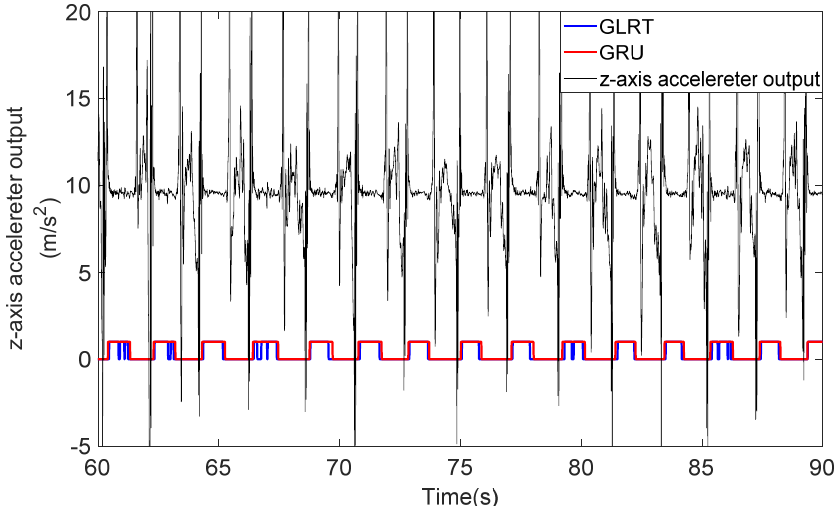
Figure 6. Zero − velocity detection result.